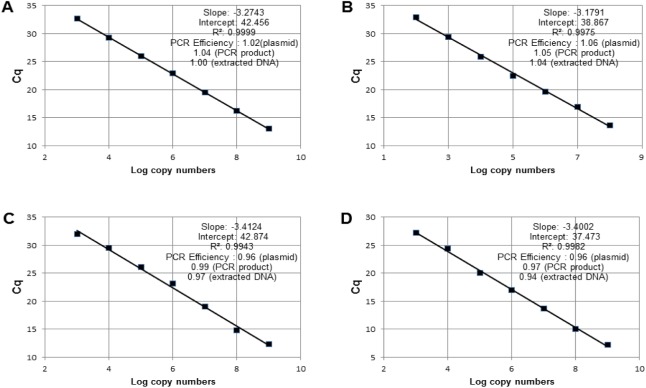
Standard curve of each qPCR primer produced using 10-fold serial dilutions of plasmids containing 18S rDNA sequences of C. calcitrans (A), I. galbana (B), P. helgolandica (C) and N. oculata (D) as a standard template and values of slope, intercept, correlation (R2) and PCR efficiencies.